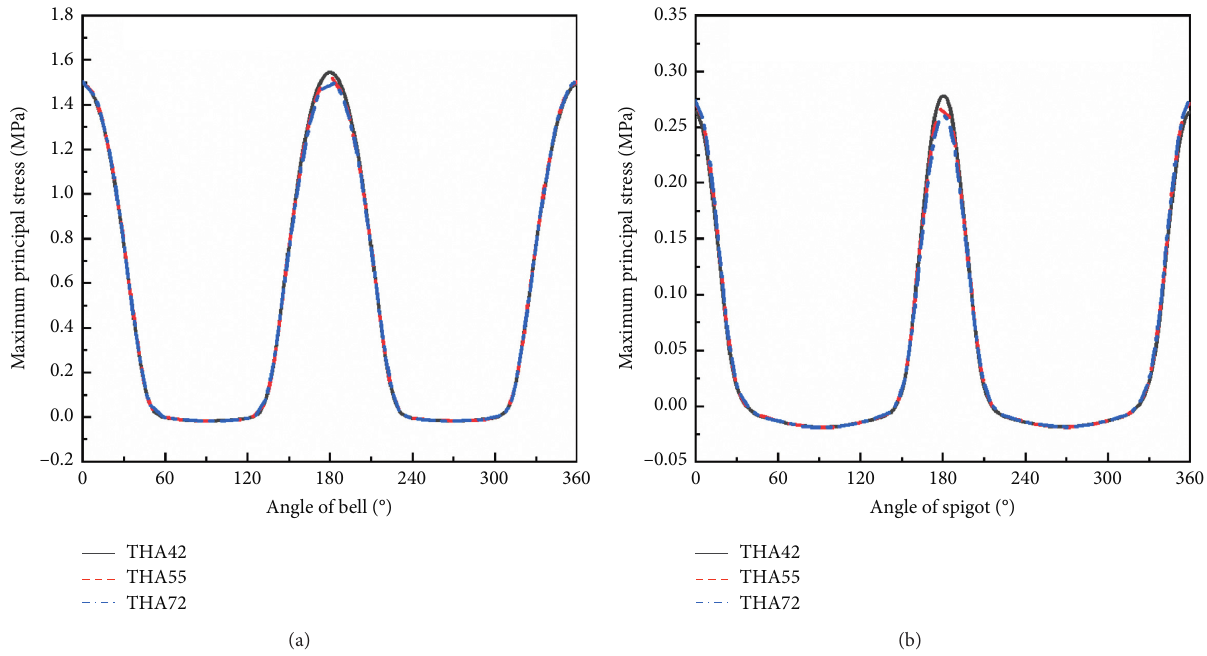
Figure 17: Maximum principal stress of (a) the bell and (b) the spigot under different gasket hardness.